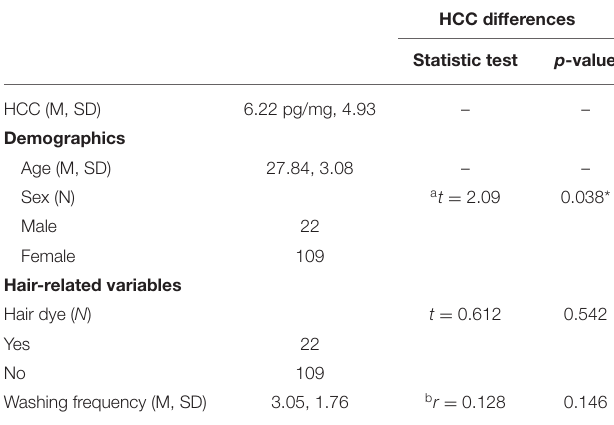
TABLE 1 | Descriptive data of the sample and hair cortisol concentrations (HCC).